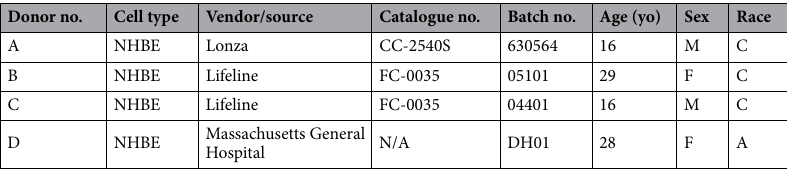
Table 1. Summary detailing the primary normal human tracheobronchial epithelial cells (NHBEs) used to grow human airway tissue within the PREDICT96-ALI platform. Vendor, catalogue number, batch number (donor lot), age, sex and race of each donor provided. M male, F female, C Caucasian, A Asian (non-Hispanic).